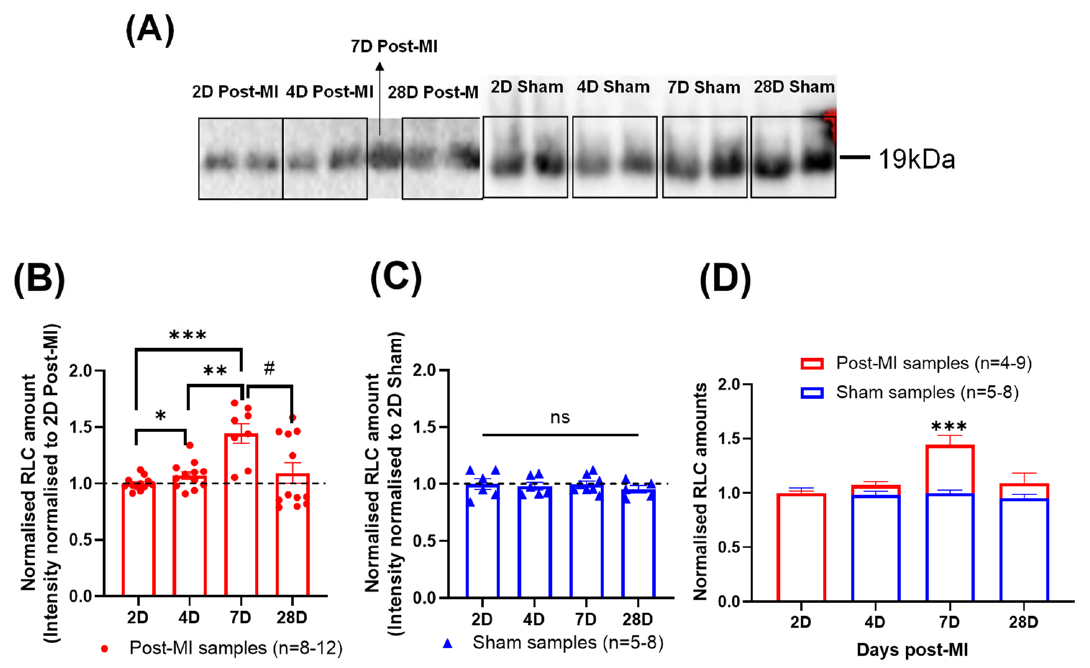
Figure 7. Changes in the quantity of RLCs suggesting losses in diseased mouse sarcomere. ( A ) Blot image of RLC of post ‐ MI and sham groups at different time points ranging between 2D and 28D post ‐ MI. ( B ) Bar graph of normalised RLC amounts at different time points for post ‐ MI groups. Unpaired one ‐ tailed t ‐ test with Welch’s correction (*) was used between 2D and 4D, 2D and 7D and 4D and 7D samples. Mann ‐ Whitney one ‐ tailed test (#) was performed between 7D and 28D samples. Kruskal ‐ Wallis test indicated that the medians varied significantly among samples ( p = 0.0194). All samples were normally distributed (except 28D post ‐ MI), as validated by Shapiro ‐ Wilk test. There were significant differences in the standard deviations, except between 4D and 7D post ‐ MI and 7D and 28D post ‐ MI, as validated by F ‐ test. Results were obtained from at least two mice for post ‐ MI samples. Note: n = 4 ‐ 9, where ‘ n ’ refers to the number of technical replicates; * p < 0.05, ** p < 0.01, *** p < 0.001, # p < 0.05. ( C ) Bar graph of normalised RLC amounts at different time points for sham groups. Ordinary one ‐ way ANOVA showed no significant differences among population means. Sample populations were normally distributed, as validated by Shapiro ‐ Wilk test. No statistical sig ‐ nificance detected between timepoints, validated by F ‐ test. Results were obtained from one mouse for sham samples. Note: n = 5 ‐ 8, where ‘ n ’ refers to the number of technical replicates. ( D ) Superim ‐ posed graph of post ‐ MI and sham samples. Unpaired one ‐ tailed t ‐ test with Welch’s correction was